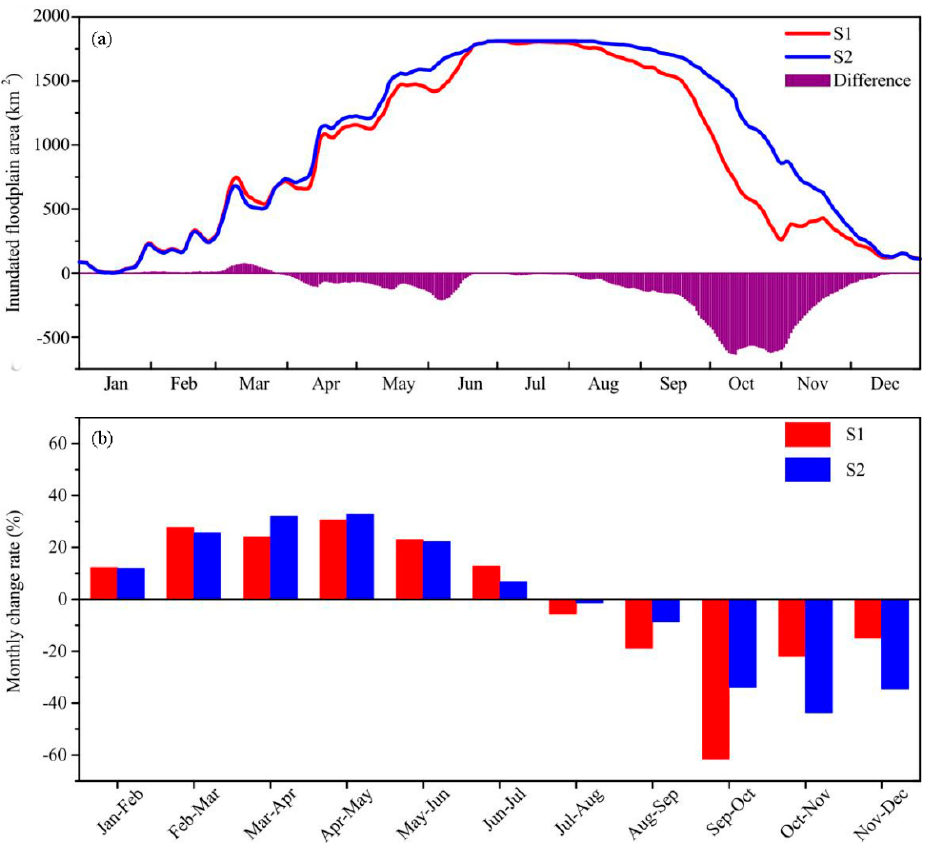
Figure 4. ( a ) Variations in the inundation area of the Poyang Lake floodplains for S1 and S2. The differences of the inundation area between S1 and S2 are also presented. ( b ) Comparison of the change rates for the monthly inundation area between S1 and S2 (S1–S2). Positive values in ( b ) indicate expansion of the inundated floodplains, and negative values indicate shrinkage of the inundated floodplains.